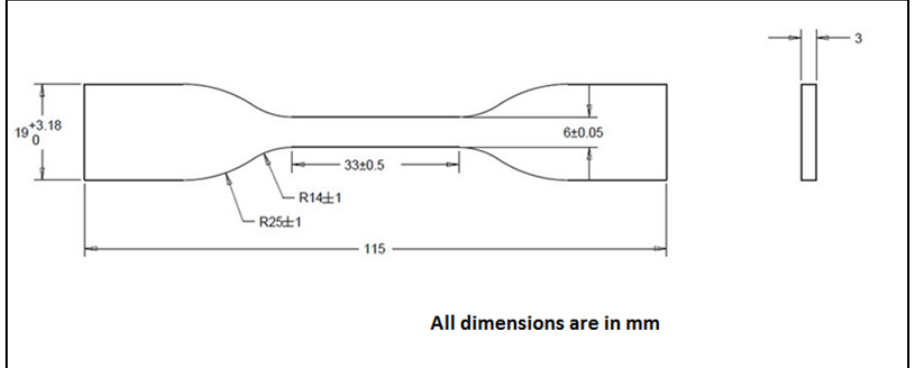
Figure 2. Tensile specimen geometry and dimensions .